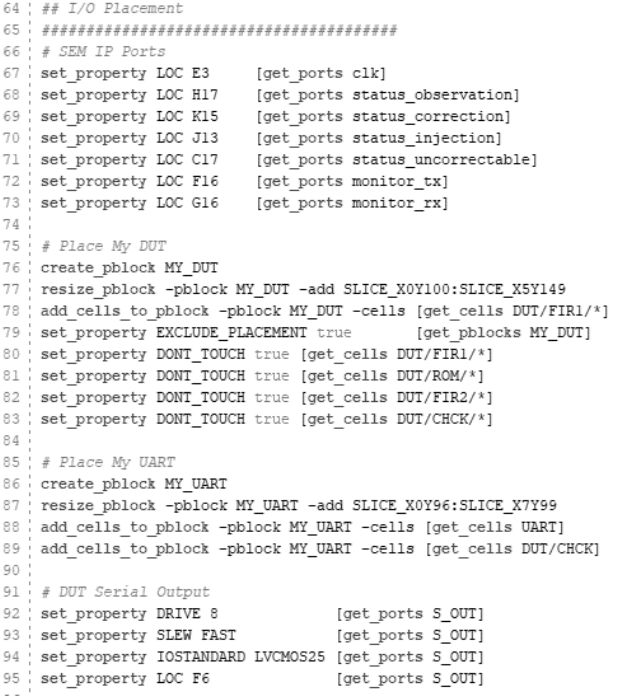
Figure 15. Constraint file example.